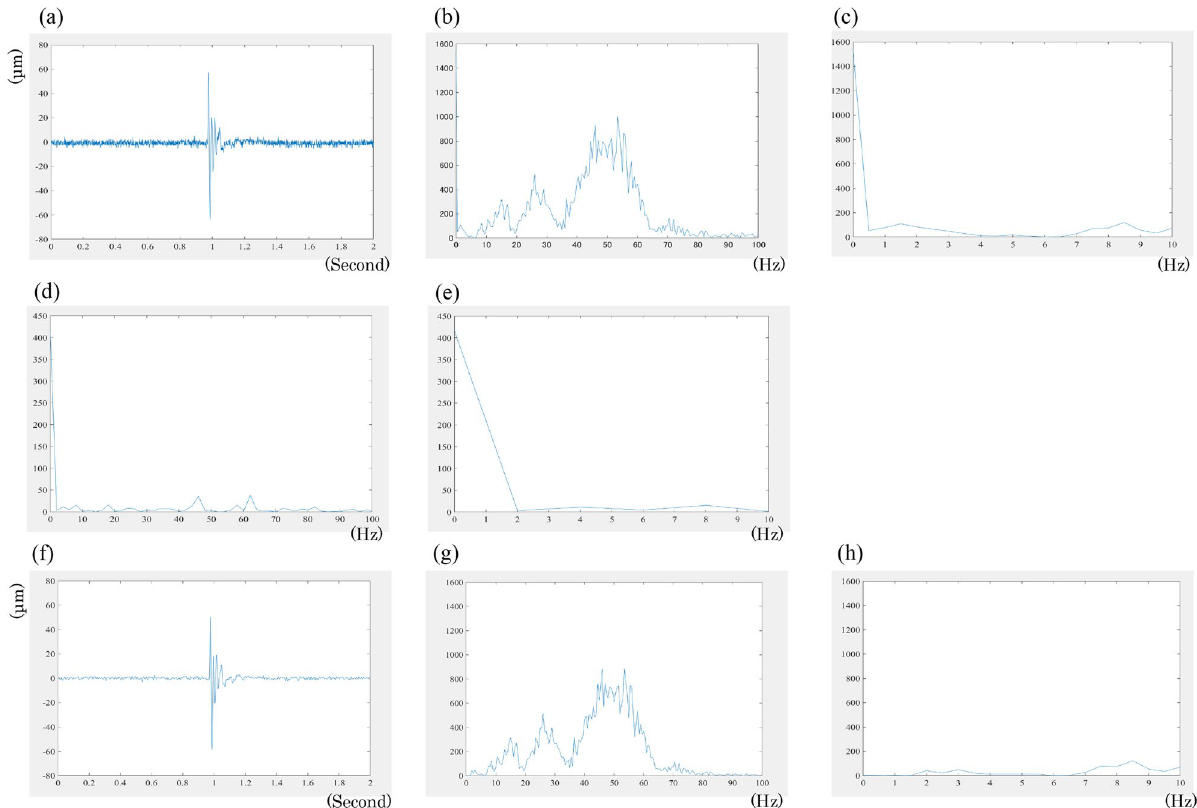
Figure 7. ( a ) A typical raw MMG waveform. Frequency analysis using an FFT algorithm for the raw waveform of the 0.5 ms after the peak wave ( b ) and below 10 Hz ( c ). FFT for the baseline waveform ( d ) and below 10 Hz ( e ); noise was included below 2 Hz. ( f ) An MMG waveform after filtering through a 2–100 Hz bandpass filter. Next, FFT for the waveform of the 0.5 ms after the peak was performed for frequency analysis ( g ) and below 10 Hz ( h ); noise was excluded. MMG, mechanomyography; FFT, fast Fourier